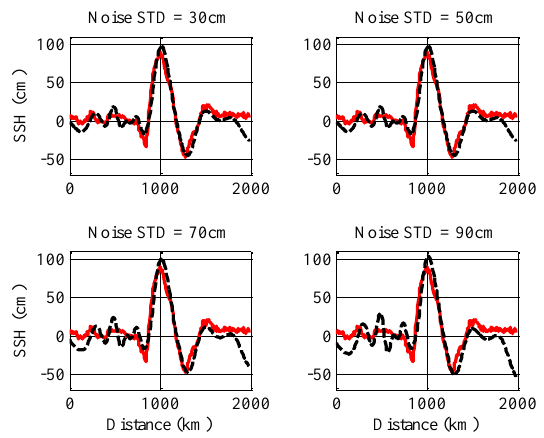
Figure 4. Effect of measurement noise standard deviation on lead wave reconstruction.